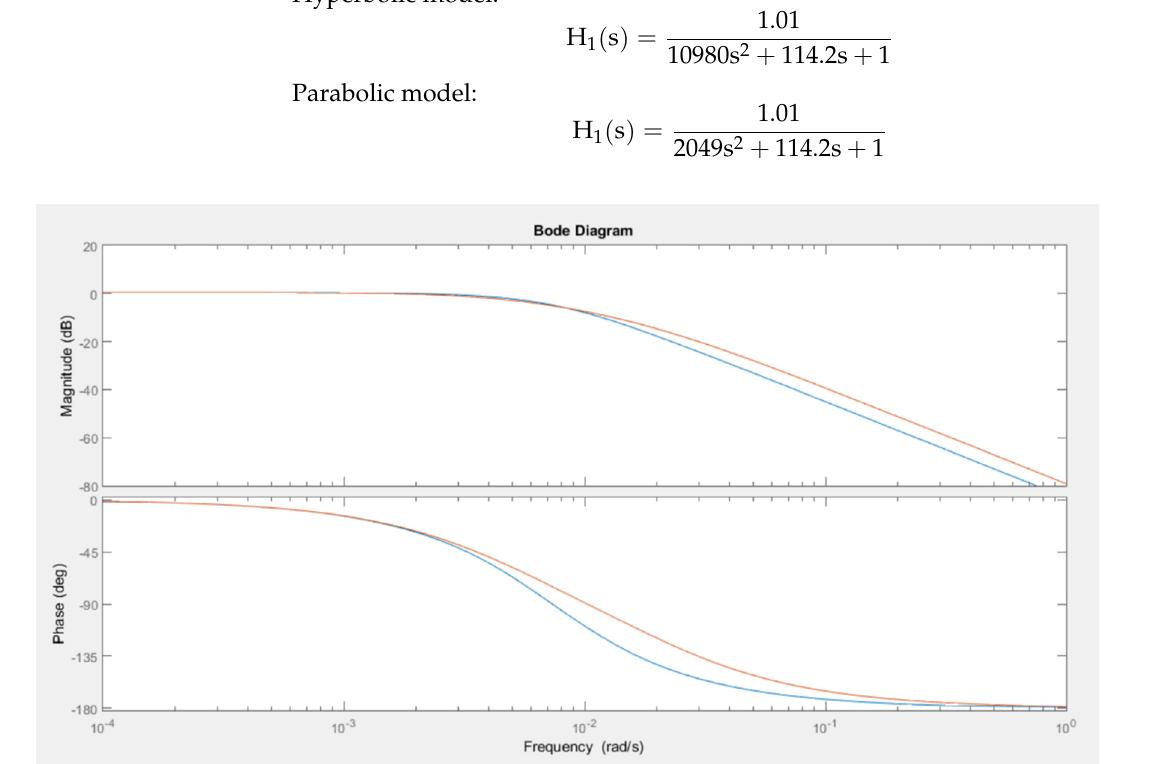
Figure 4. Length = 50 km, diameter = 1 m, mass flow = 240 kg/s, T ∈ (0.5 h;24 h). The parabolic model is plotted in red, while the hyperbolic model—in blue. (d) For L = 50 km, D = 1.0 m, and mass flow = 240